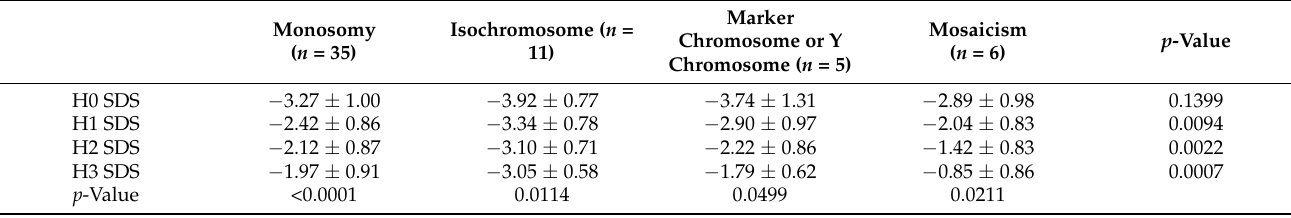
Table 3. Mean values ( ± SD) of the height deficiency in particular groups of girls with TS before treatment and after 1, 2, and 3 years of rhGH therapy.